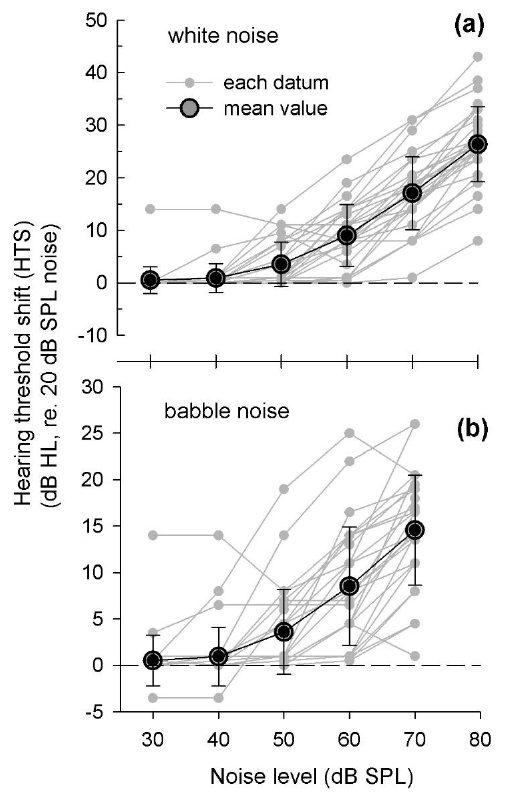
Figure 4. An example of the hearing threshold shift as a function of the white ( a ) and babble ( b ) noise level. Individual data (small grey circles, n = 15) and the mean hearing threshold shift are plotted versus the noise level.